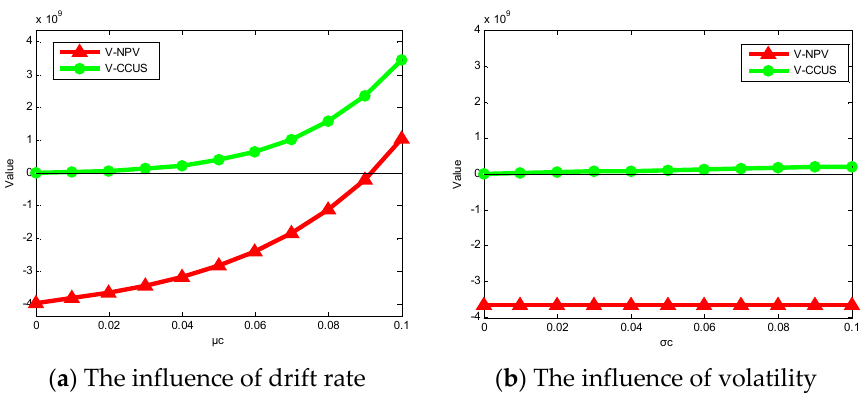
Figure 5. The impact of price uncertainty on NPV and the investment value of CCUS.